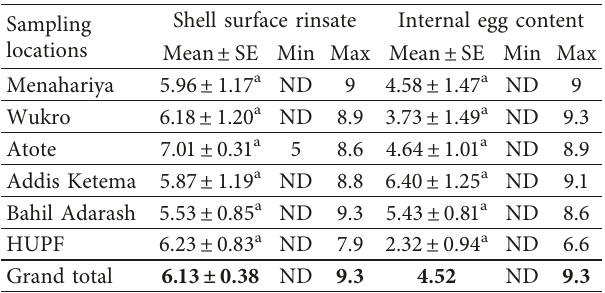
Table 7: Enterobacteriaceae count (EC) in log surface rinsates and contents of egg samples in Hawassa City, southern Ethiopia,